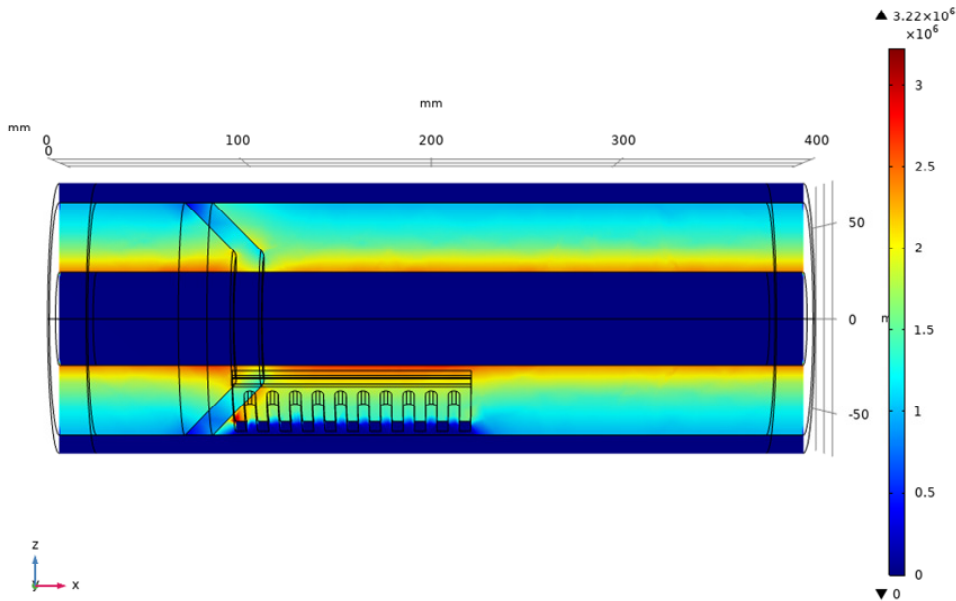
Figure 6. Electric field distribution.